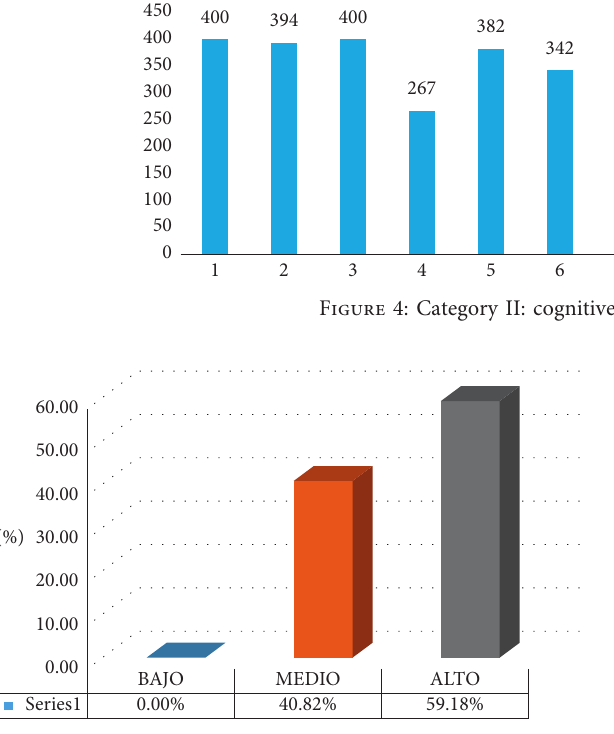
Figure 5: Category II: cognitive development-content mastery: results.